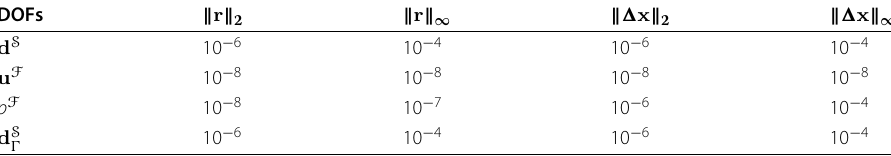
Table7 Tolerances for nonlinear convergence check for Coriolis flow meter example